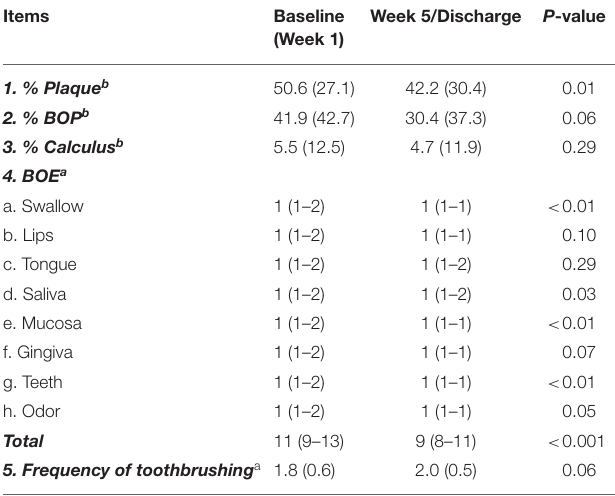
TABLE 2 | Changes in oral health parameters during hospitalization.